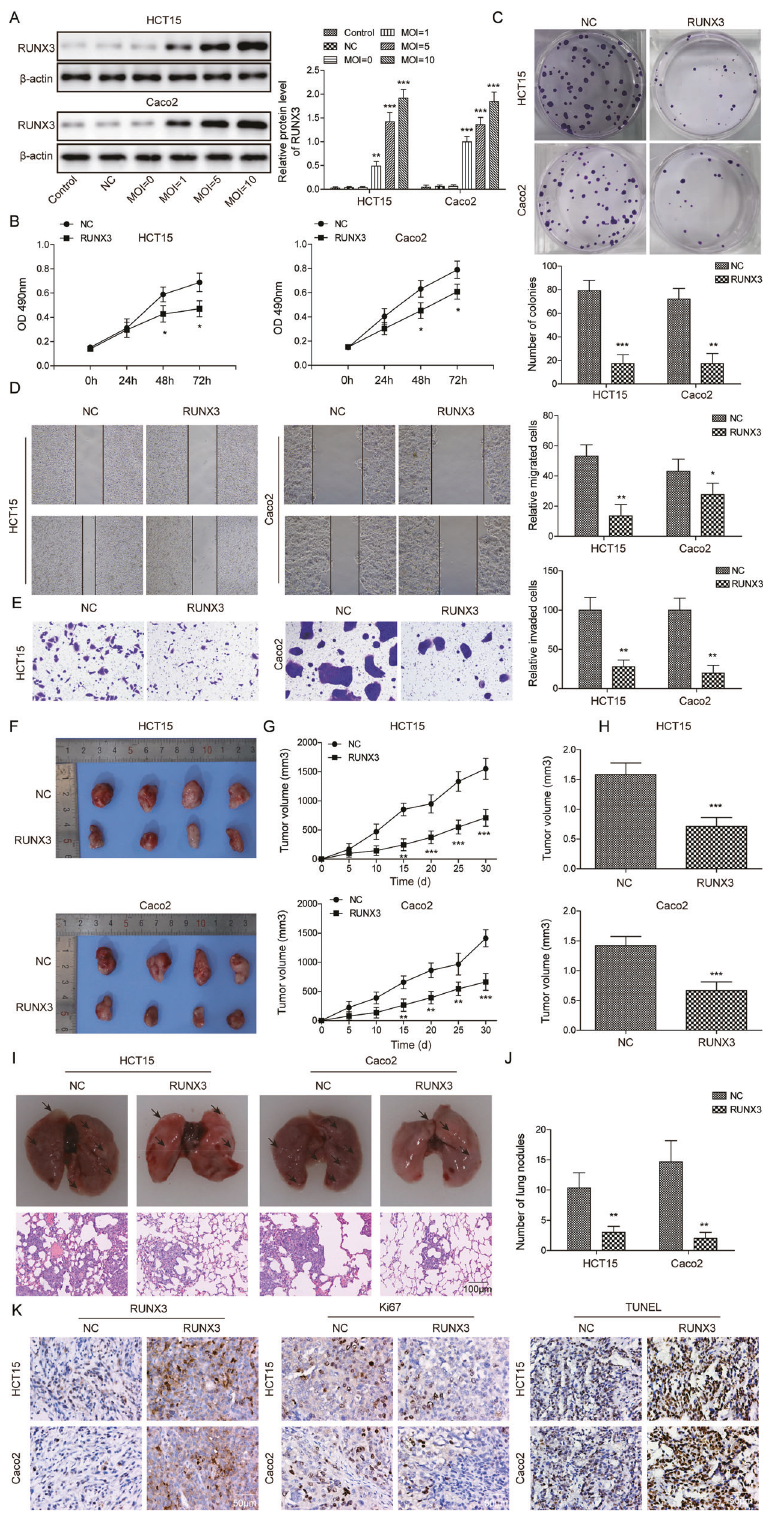
Fig. 2 Overexpression of RUNX3 suppressed proliferation and migration of CRC cells. A Relative RUNX3 levels in transfected Caco2 and HCT15 cells. B CCK-8 assay to measure cell viability. C Colony formation assay to assess cell proliferation. D Scratch wound assay to analyze cell migration ability. E Transwell assay to evaluate cell invasion ability. F Representative tumor images in mice bearing transfected Caco2 and HCT15 cells. G Tumor volume in each group of mice. H Tumor weight in each group of mice. I Representative lung images in each group of mice, and H&E staining to measure the number of tumor nodules in the lung from each group of mice. J Quanti fi cation of the number of tumor nodules in the lung. K IHC staining and TUNEL staining to analyze RUNX3/Ki67 expression and apoptosis of cancer cells in each group.